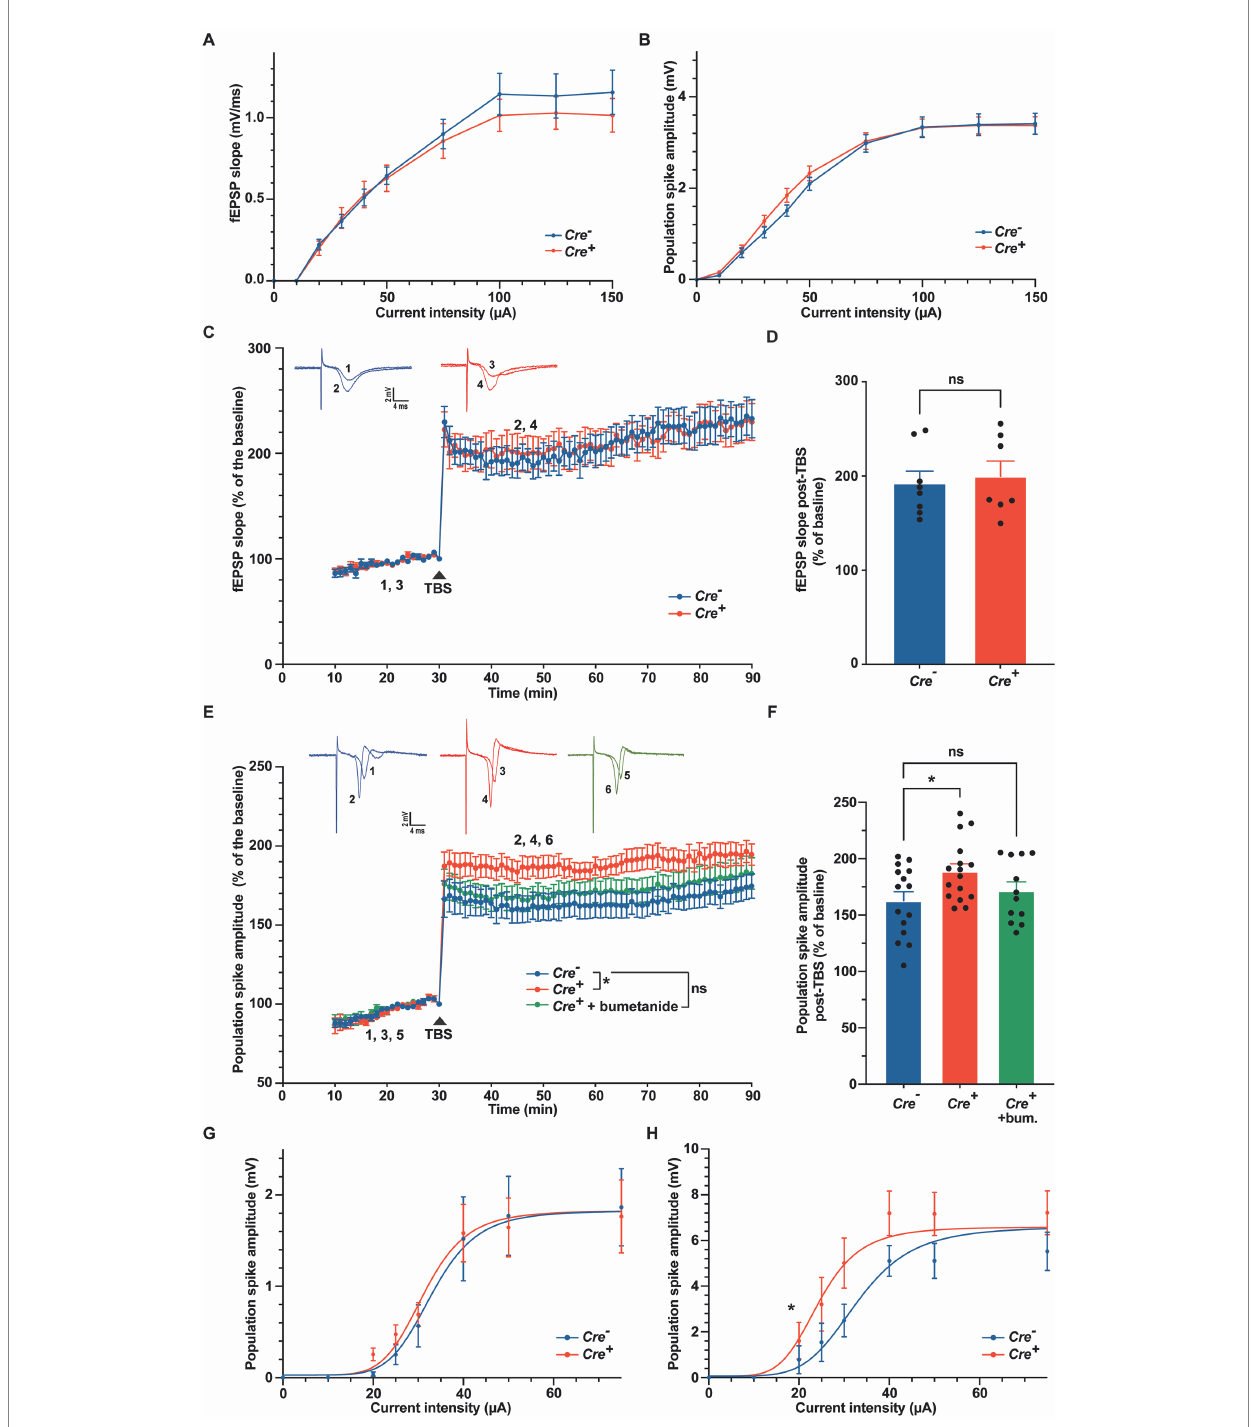
FIGURE 5 Long-term potentiation in the stratum radiatum and in the stratum pyramidale in Cre − and Cre + animals. (A,B) Input–output relations measured in the stratum radiatum (A) , n = 9 for Cre − , n = 7 for Cre + ) and in the stratum pyramidale (B) , n = 27 for Cre − , n = 44 for Cre + ). ( C,D) . fEPSP recordings in the stratum radiatum of the CA1 region before and after TBS (slope values normalized to the pre-TBS baseline). Upper insets show representative traces of fEPSP before (1, 3) and 30 min after TBS (2, 4). Time course (C) and quantification (D) for the period between 15 and 30 min after TBS, i.e., between timepoints 45 and 60 min on panel C ( n = 8 for Cre − , n = 7 for Cre + , two-way ANOVA (time and genotype) for panel C , unpaired t -test for panel (D–F) . Population spike recordings in the stratum pyramidale CA1 cell layer before and after TBS (amplitude values normalized to the pre-TBS baseline). Upper insets show representative traces of population spikes before (1, 3, 5) and 30 min after TBS (2, 4, 6). Time course (E) and quantification (F) for the period between 15 and 30 min after TBS ( n = 20 for Cre − , n = 22 for Cre + , and n = 18 for Cre + treated with 10 μ M bumetanide). * p -value ≤ 0.05; one-way ANOVA with Dunnett’s multiple comparison test. (G,H) Input–output relations measured in the stratum pyramidale 30 min before ( n = 10 for Cre − and n = 13 for Cre + ) and 30 min after TBS ( n = 12 for Cre − and n = 13 for Cre + ). Non-linear least squares regression. * p -value ≤ 0.05; Extra sum-of-squares F